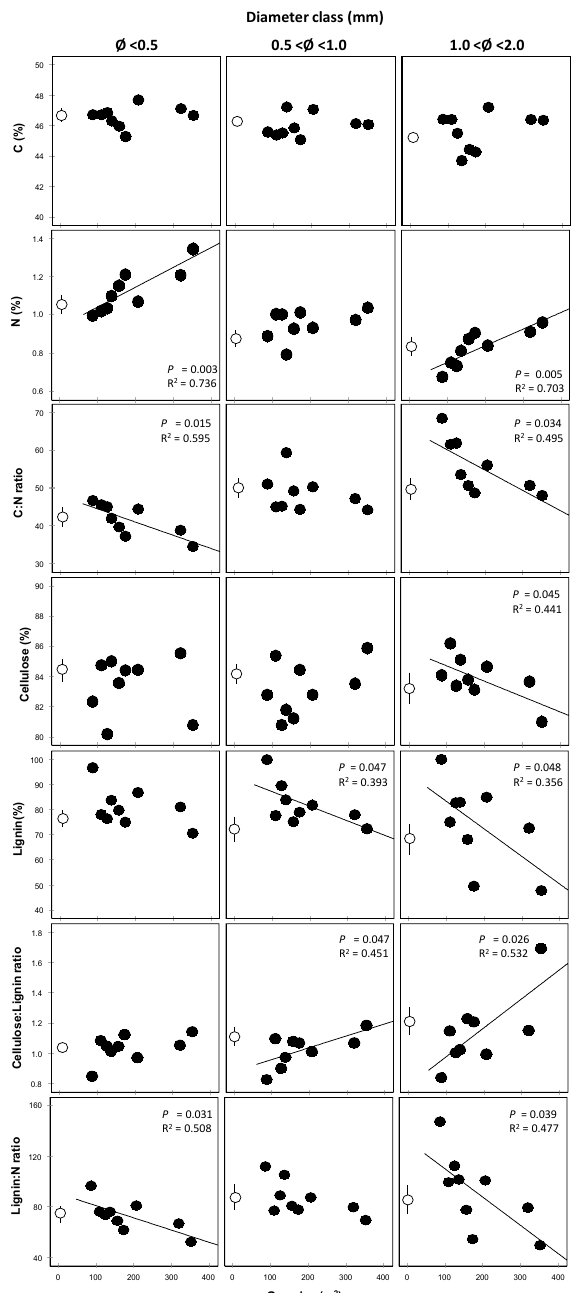
Figure 4. Fine root chemical traits (rows) in relation to gap size, according to three diameter classes (<0.5, 0.5–1, and 1–2 mm) (columns). Points represent one value per 9 gap sizes only (see Section 2.4); the uncut control, not included in the regression analysis, was conventionally assigned the gap size value of 1 m 2 and represents the mean of 9 replicates ± SE (see Section 2.5). If significant at p <0.05, regression lines and the corresponding R 2 were shown.